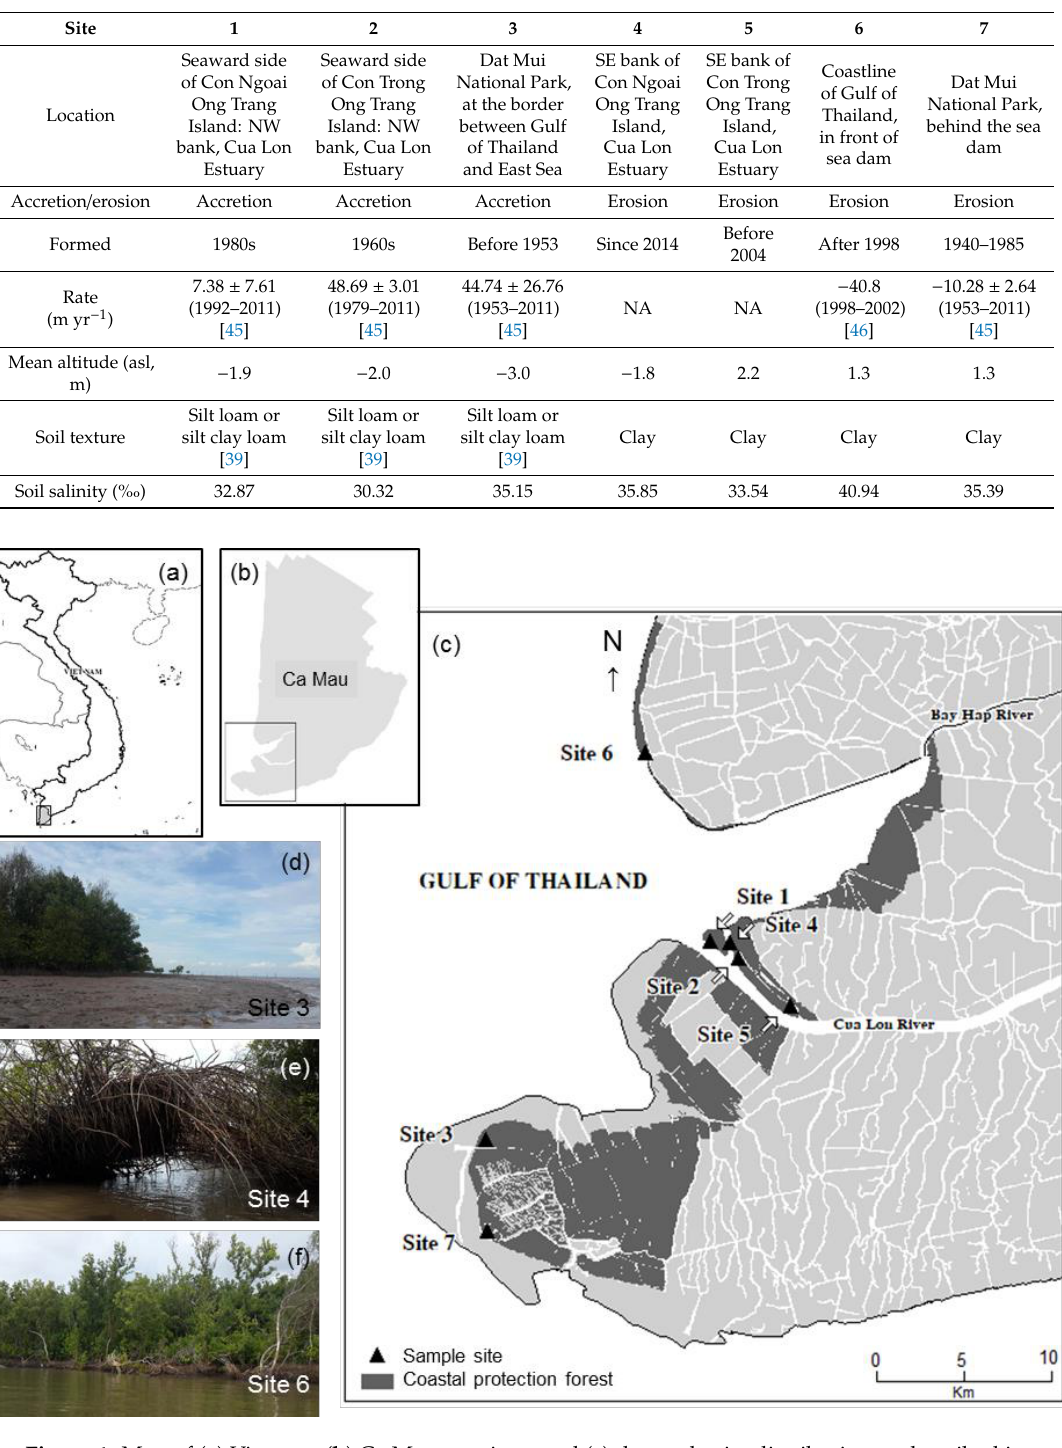
Table 1. Topographic and coastal characteristics of the study sites.